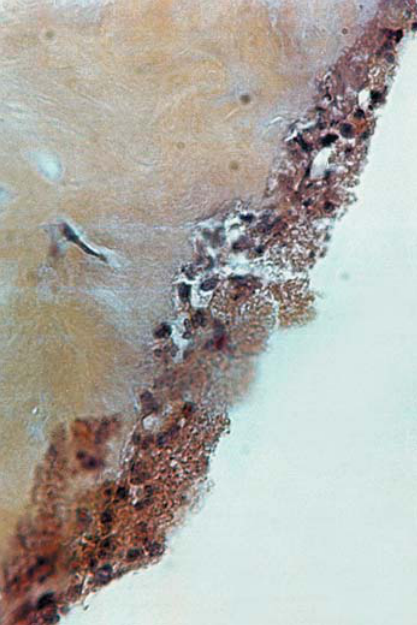
FIGURE 6a- Amplification of the rectangle area in Figure 6. Periapical biofilm of predominantly gram-negative microorganisms, Brown & Brenn - 1000X